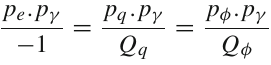
final state particles, 2 the modulus squared matrix